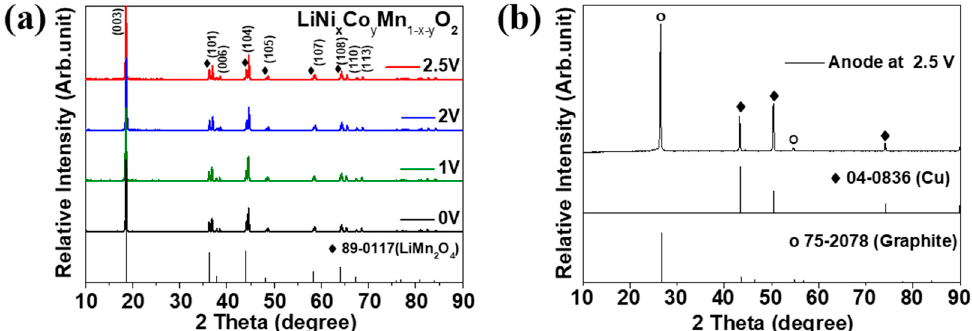
Figure 7. X-ray diffraction analysis of the ( a ) cathode of LIB cell-2 discharged to various cut-off potentials and ( b ) anode of LIB cell-2 discharged to 2.5 V.